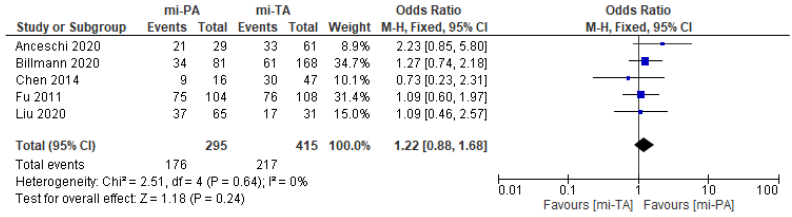
( e ) Forest plot representing analysis of patients with no ‐ standardized absent clinical success.